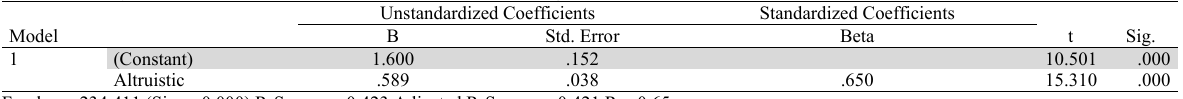
The summary of the effect of Altruistic on decision-making Model